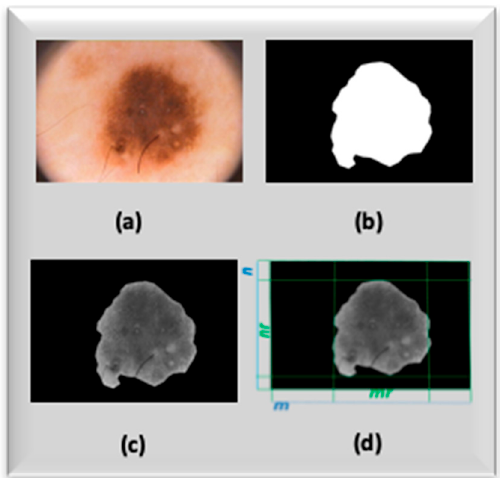
Figure 4. ( a ) Original RGB dermoscopy image, ( b ) image-mask provided by PH 2 database, ( c ) SC-CNNs pre-processed image, ( d ) segmented SC-CNNs pre-processed image with details.